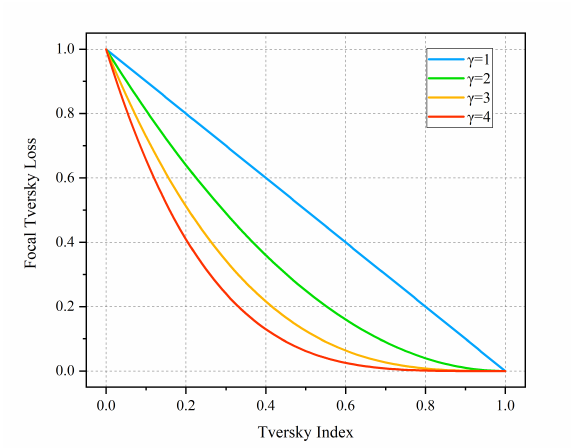
Figure 9. The trend diagram of Focal Tversky Loss under different γ values (The Focal Tversky Loss focuses training on difficult samples (Tversky index < 0.5) and suppresses the contribution of simple samples (Tversky index > 0.5) to the loss